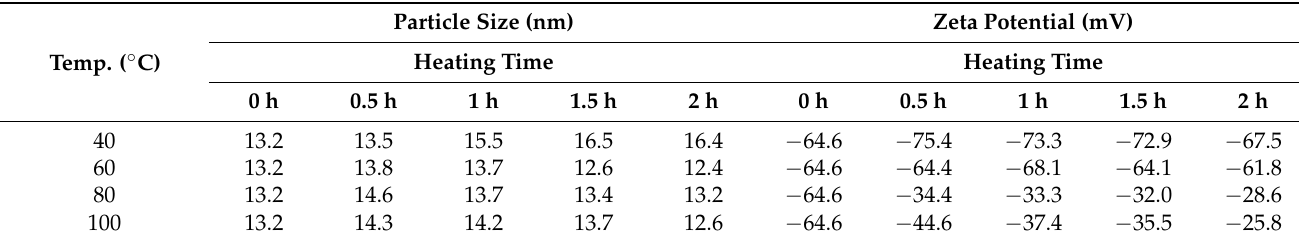
Table 3. Particle size and zeta potential change as affected by chlorophyll nanoemulsion during heating at 40–100 °C for varied length of time. Temp.